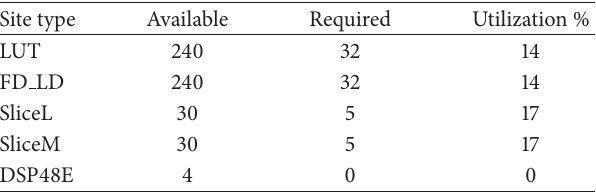
Table 9: Resources utilization of an adder in a PRR for the uniform implementation (Virtex-V).